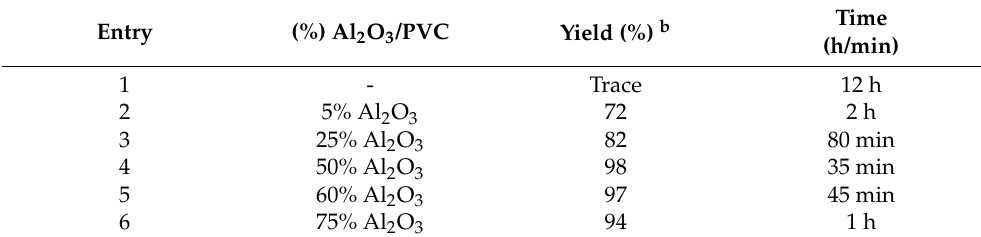
Table 2. Effects of the Al 2 O 3 /PVC catalyst loaded with different amounts of Al 2 O 3 on the synthesis of model compound ( 4a ) a